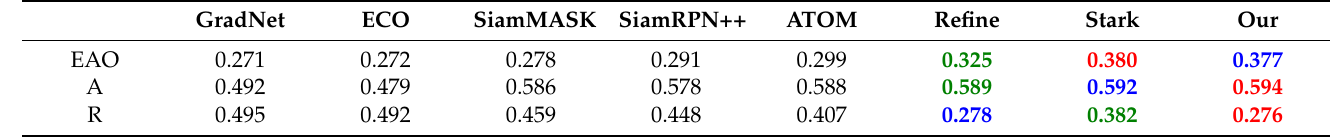
Table 3. Comparison with state-of-the-art trackers on VOT-2019. ( Red , Blue , and Green represent the top three tracking